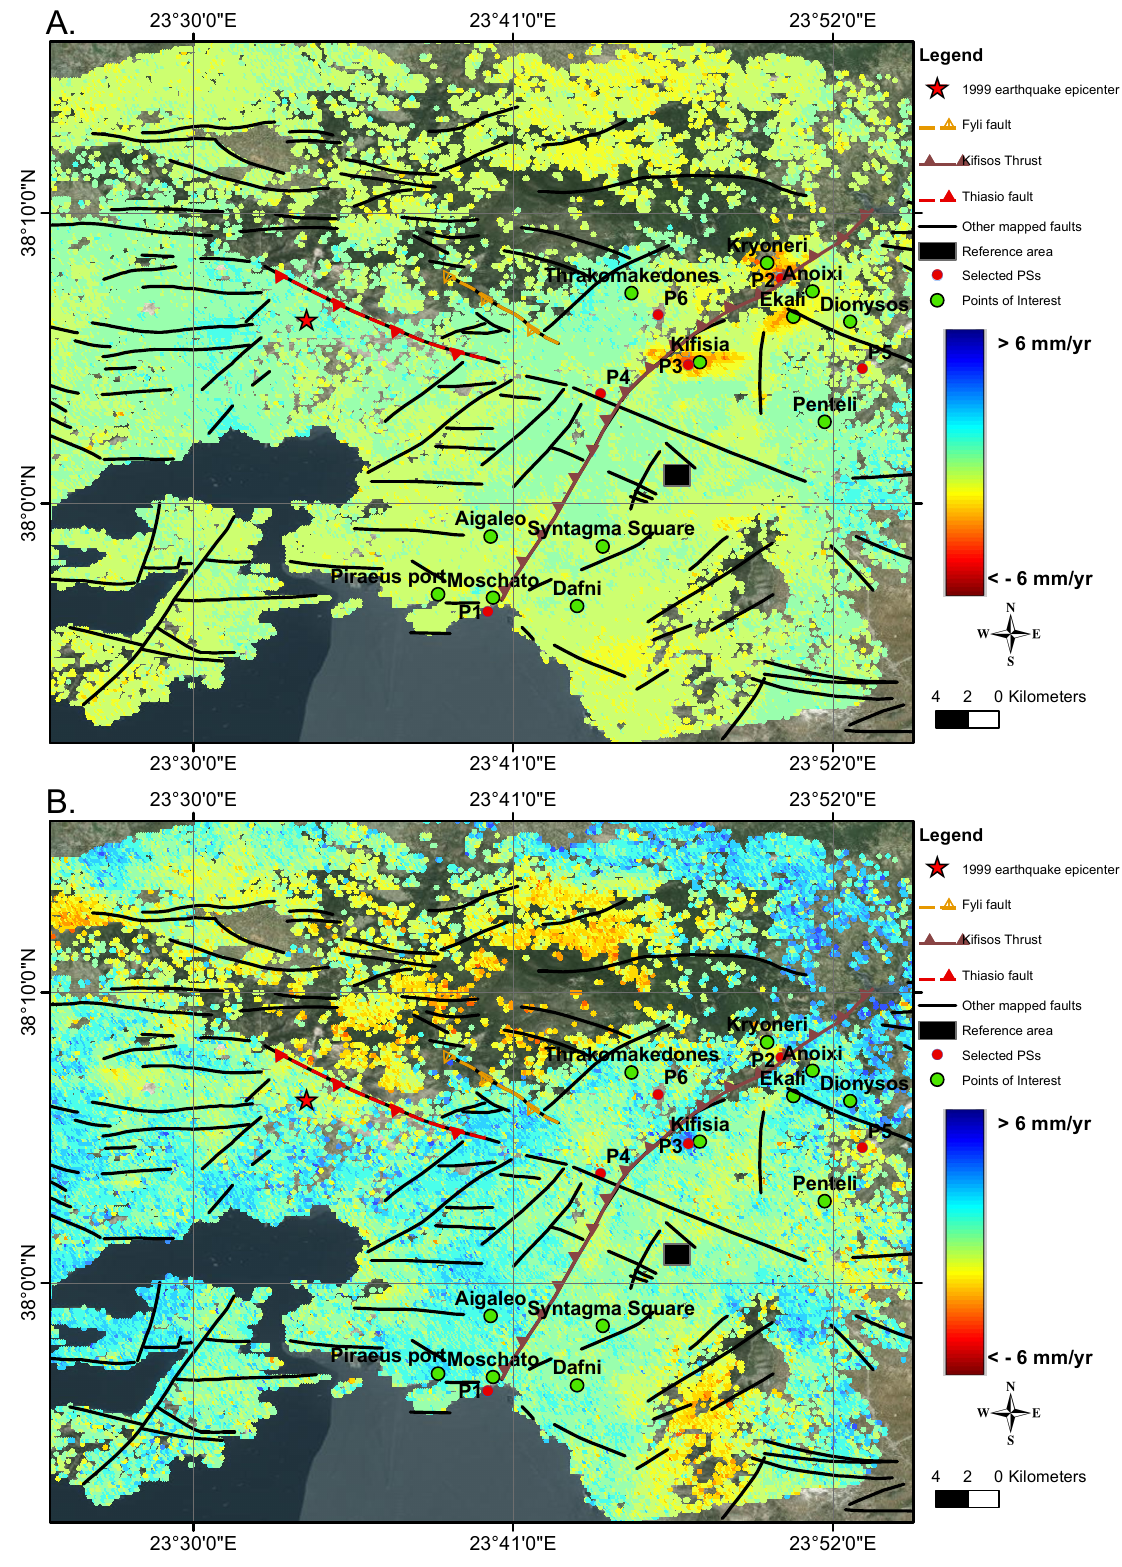
Figure 8. ( A ) Vertical and ( B ) horizontal velocities overlaid with the fault network in wider Athens for the 1992–1999 period. Among others, Kifisos thrust, the Fyli fault and the Thriasio fault, close to the Athens 1999 earthquake (star), are marked. Negative values in the up direction correspond to subsidence, while positive values in the horizontal direction correspond to westward motion. Kifisia, Kryoneri and Ekali municipalities experience primarily subsidence, while in the vicinity of the Thriasio fault, there are indications of zones with counter-force